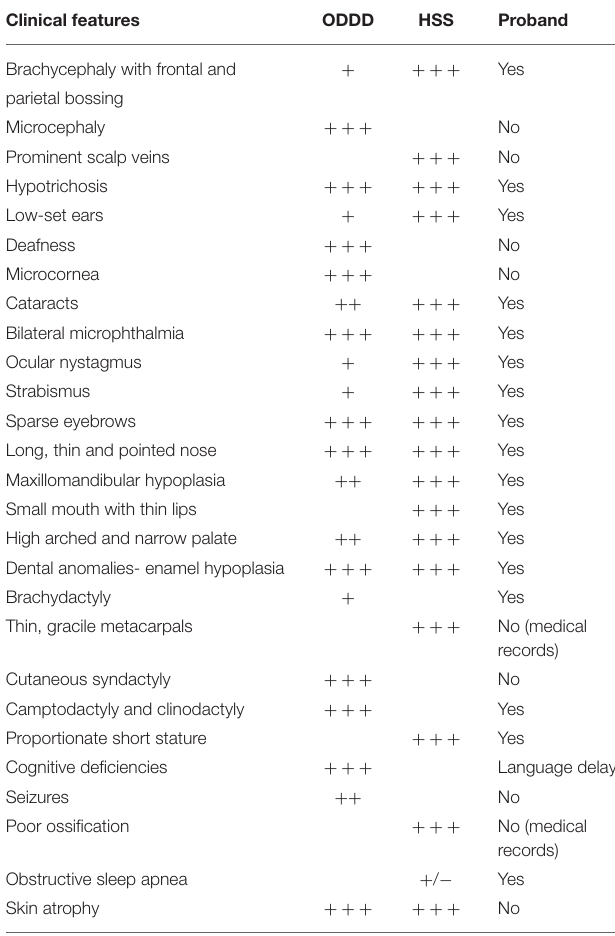
TABLE 1 | Clinical features in HSS, ODDD, and the